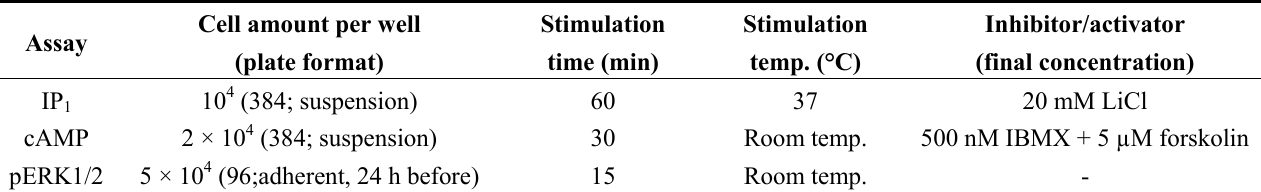
Table 1. Overview of assay conditions used for studying CaSR with an HTRF ® platform.